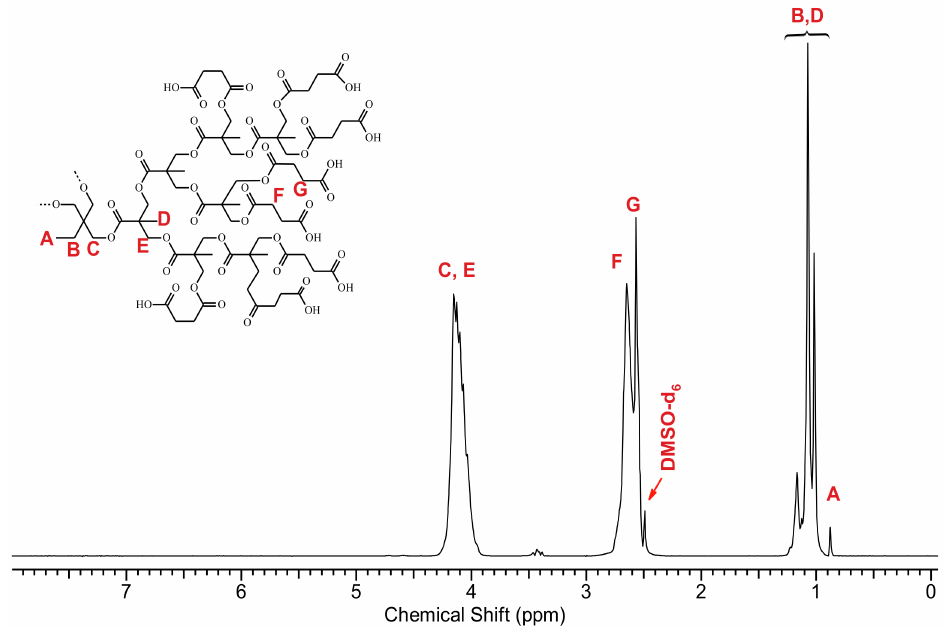
Figure 5. 1H-NMR spectrum and schematic architecture of carboxy-functionalized Boltorn H40. At the final stage of the synthesis, these compounds were sequentially reacted with 1-(3-aminopropyl)silatrane and (aminomethyl)trimethylsilane to form polymers 3 and 4.